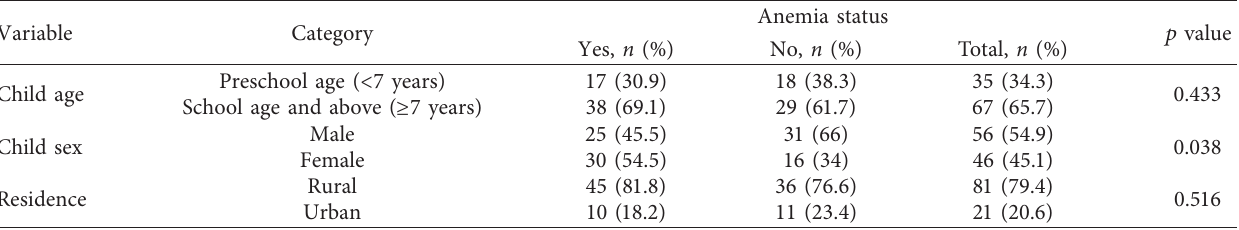
Table 1: Characteristics of the study participants by anemia status of HIV-infected children aged 6 months to 15 years, in the Afar region, Ethiopia, 2018.